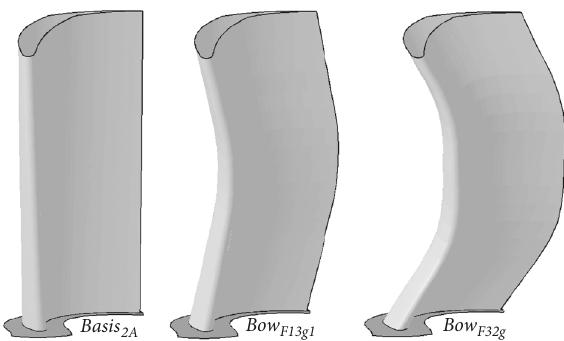
Figure 3: Schematic three-dimensional representation of the radial and the curvature guide